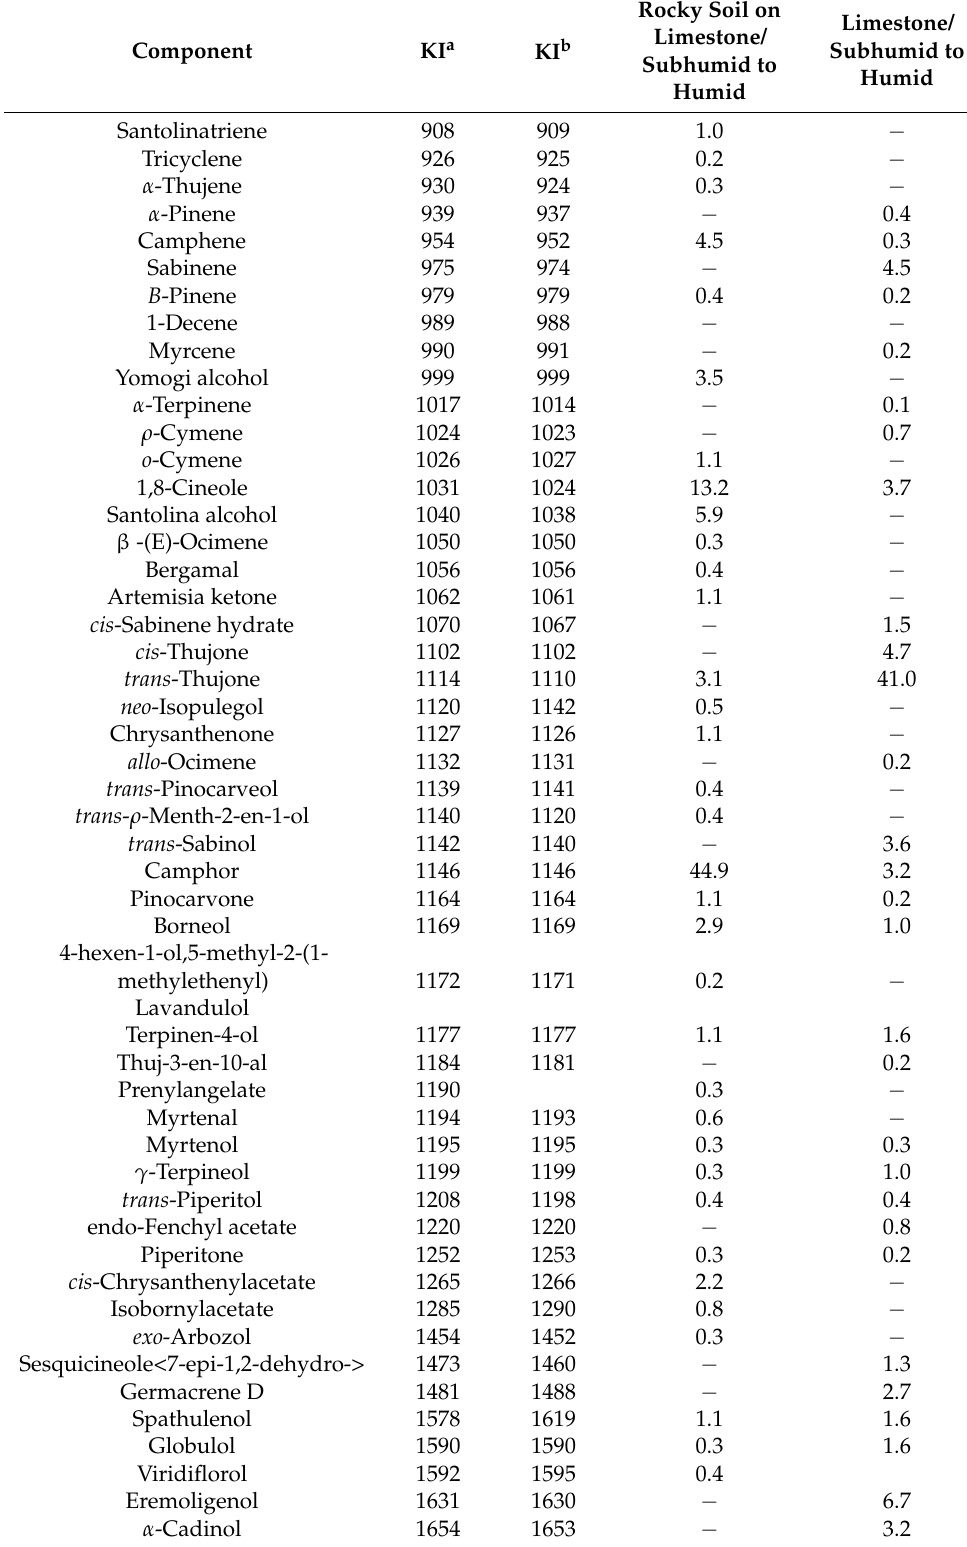
Table 3. The chemical composition of essential oil of A. mesatlantica from different locations.